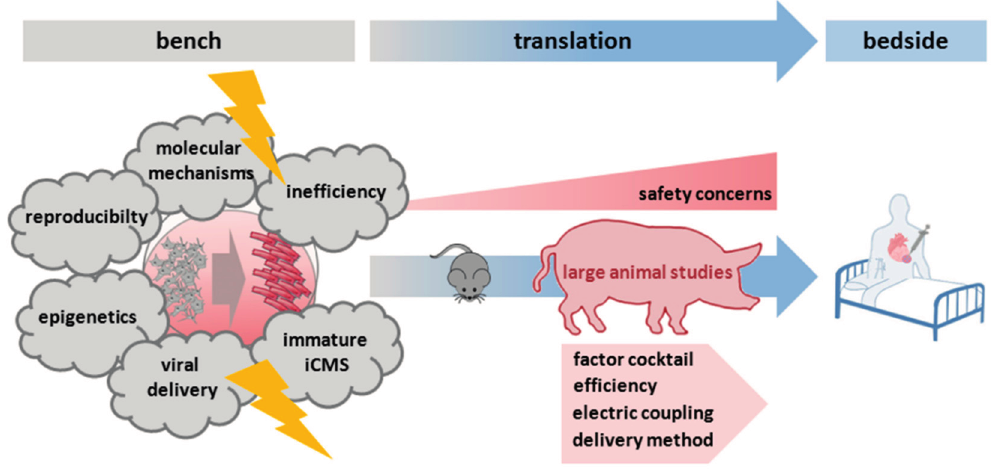
Figure 3. Remaining challenges of direct reprogramming approaches before a clinical application. Before a translation of direct reprogramming approaches from bench to bedside, several challenges have to be resolved. First of all, issues like the inefficiency of the reprogramming process from fibroblasts (grey cells in front of the arrow) to induced cardiomyocytes (iCMs, red elongated shaped cells behind the arrow), the insufficient maturity of the iCMs, the delivery method, or the understanding of underlying